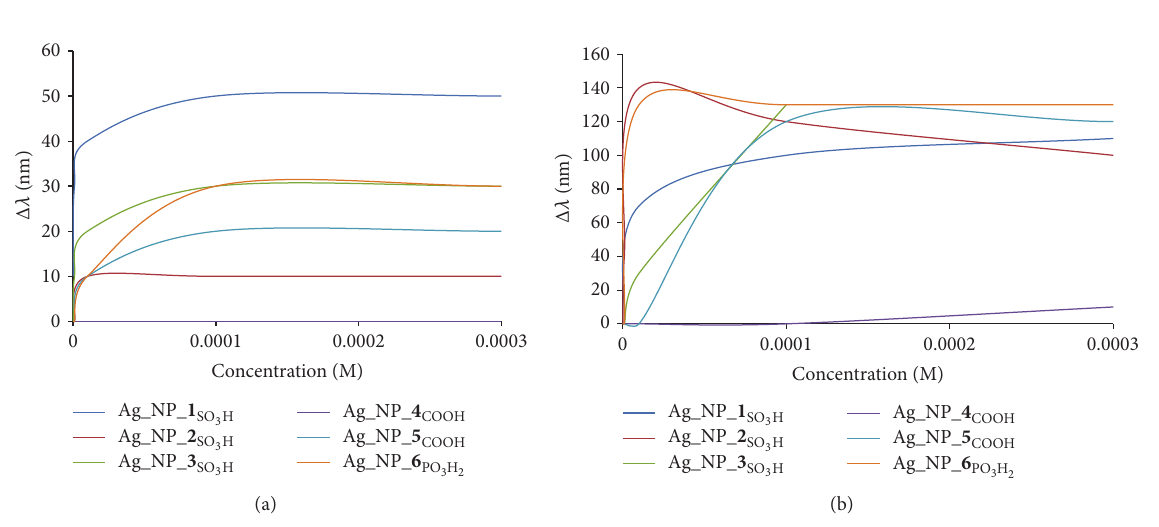
(a) chlorhexidine (b) gentamycine